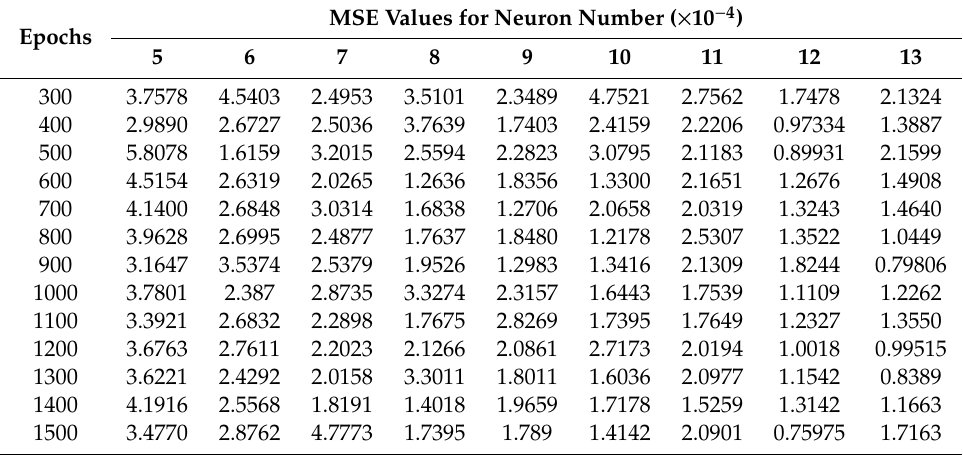
Table 7. Influence of epochs and neuron number of established IANN model on MSE values. Epochs